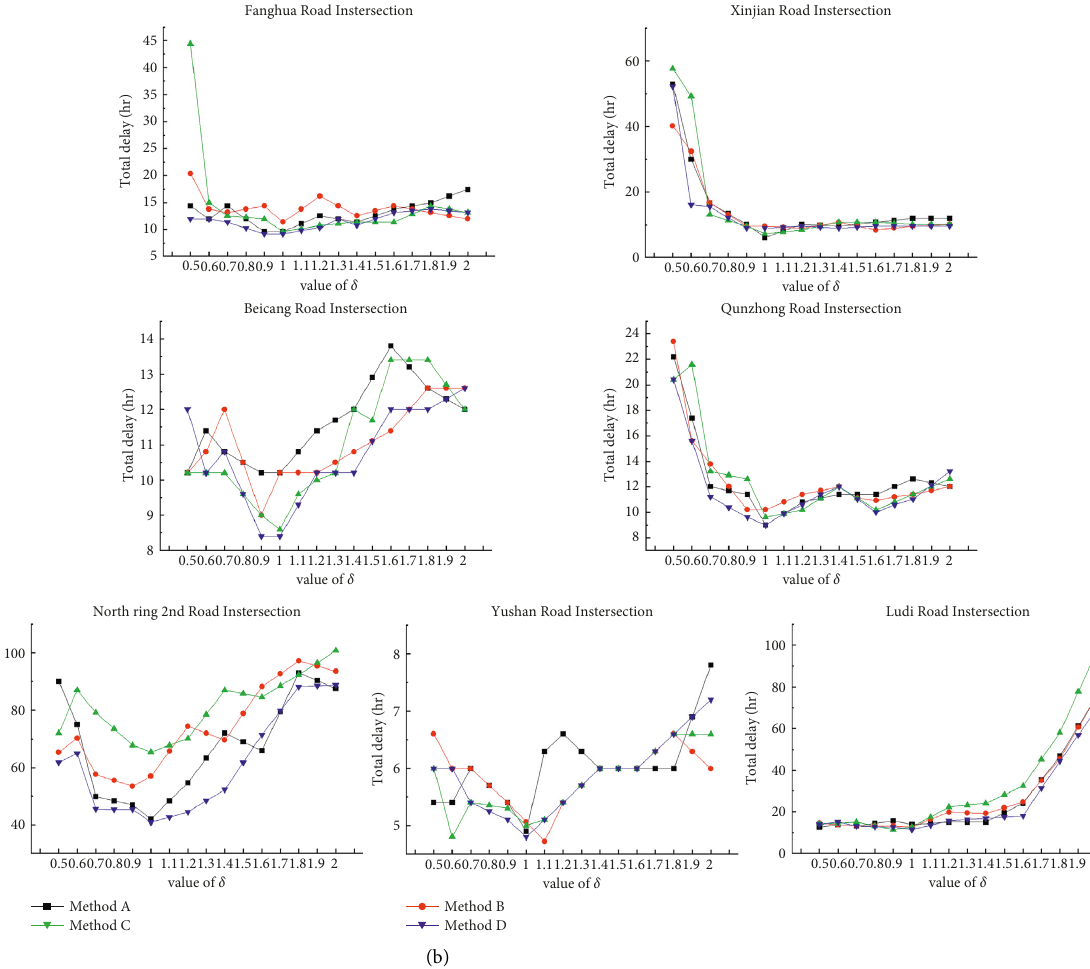
Figure 9: Delays and queue length levels at various intersections under different control methods and different traffic